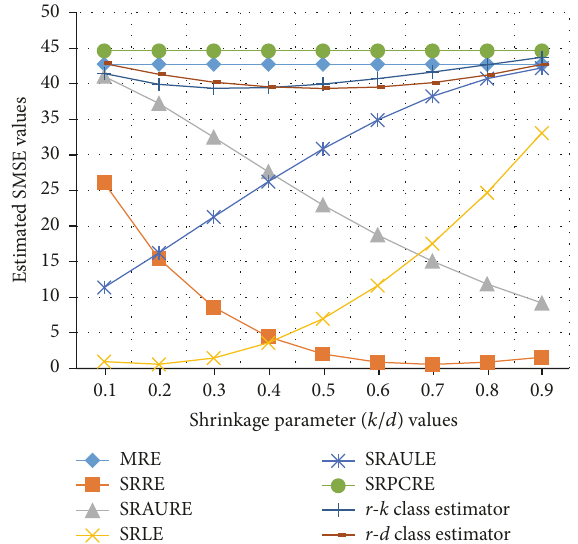
Figure 3: SMSE values of the estimators in the misspecified regression model when 𝑛 = 50 and 𝜌 = 0.999.